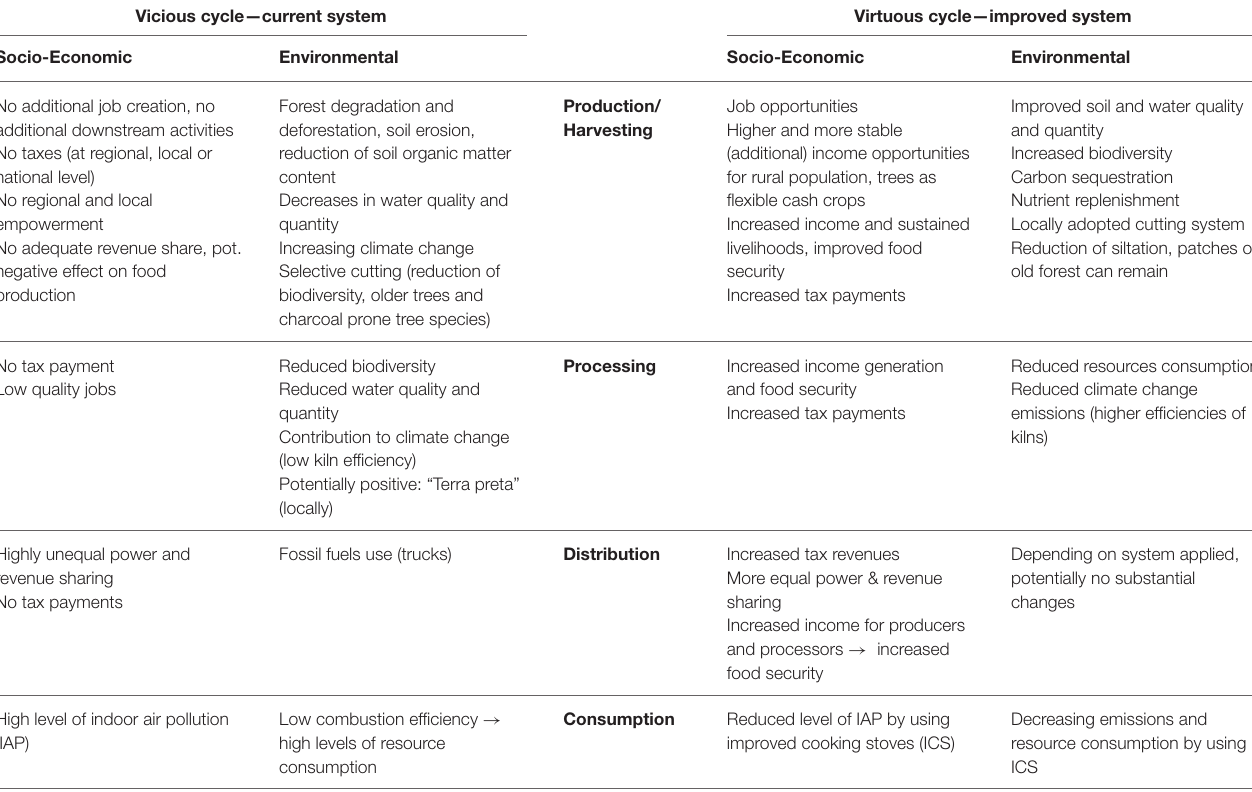
TABLE 1 | Summary of water, energy and food related implications of vicious and virtuous production cycles, separated by value chain